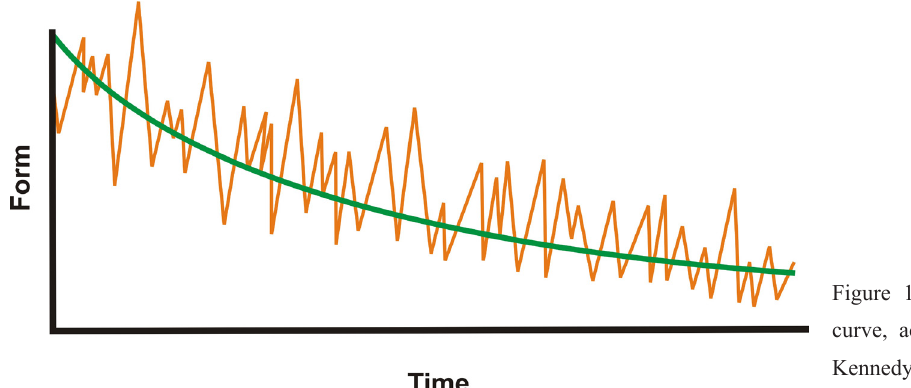
Figure 13. Dynamic equilibrium curve, according to Chorley and Kennedy